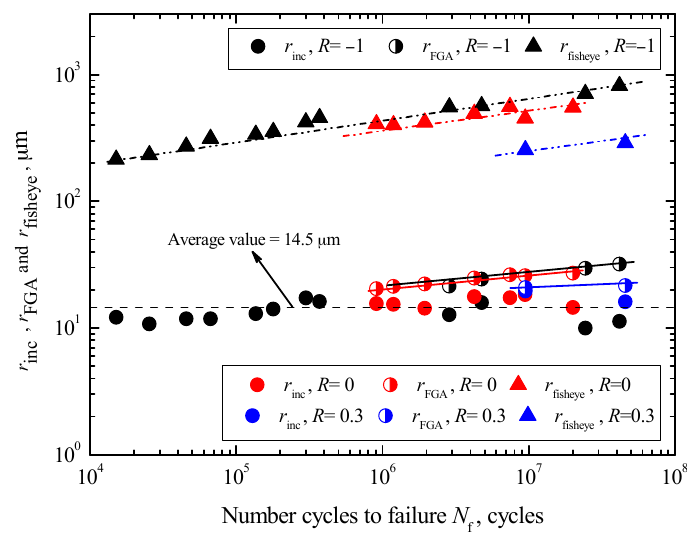
Figure 8. Relationships between r inc , r FGA , and r fisheye , and N f .